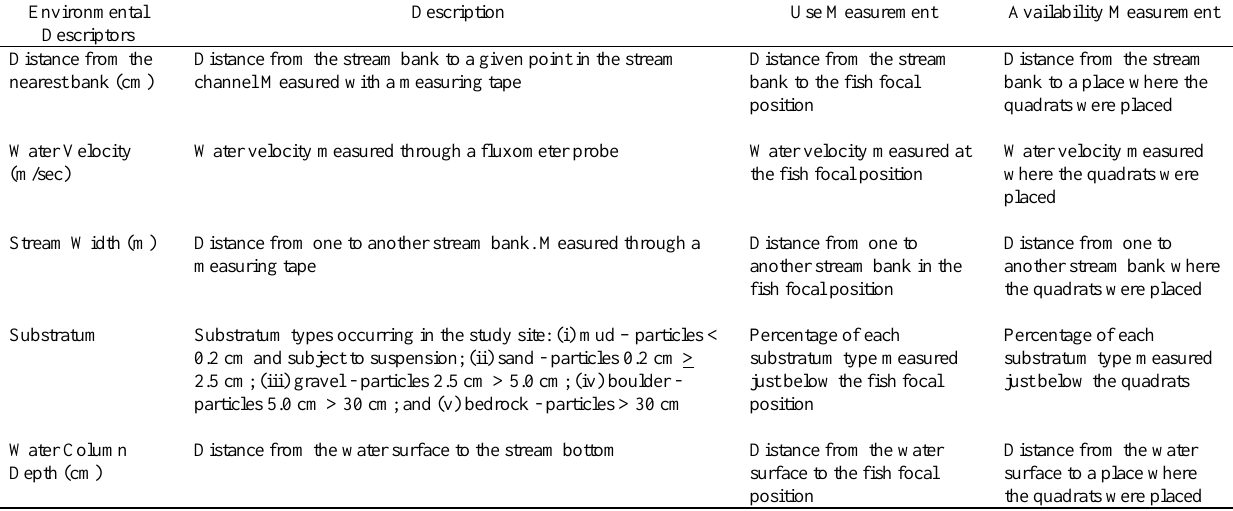
Table 1. Microhabitat descriptors and their respective measurements for fish use and environmental availability measurements applied for the microhabitat study of Astyanax taeniatus from Roncador